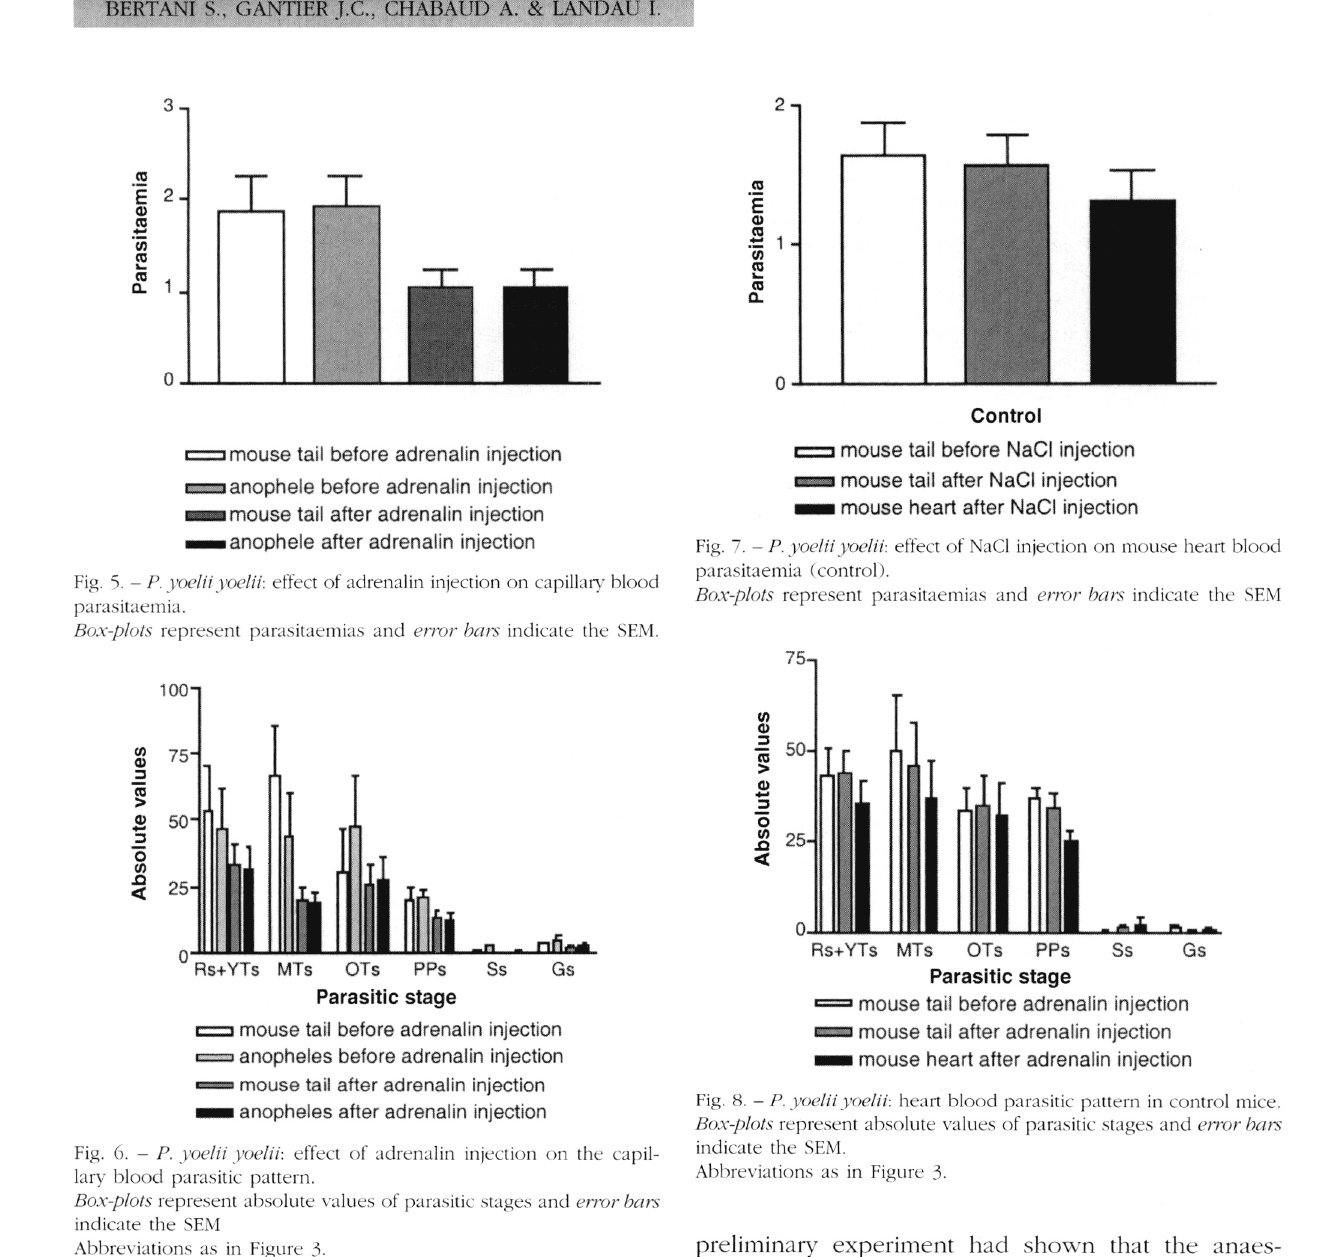
Fig. 8. - P. yoelii yoelii: heart blood parasitic pattern in control mice. Box-plots represent absolute values of parasitic stages and error bars indicate the SEM. Abbreviations as in Figure 3.